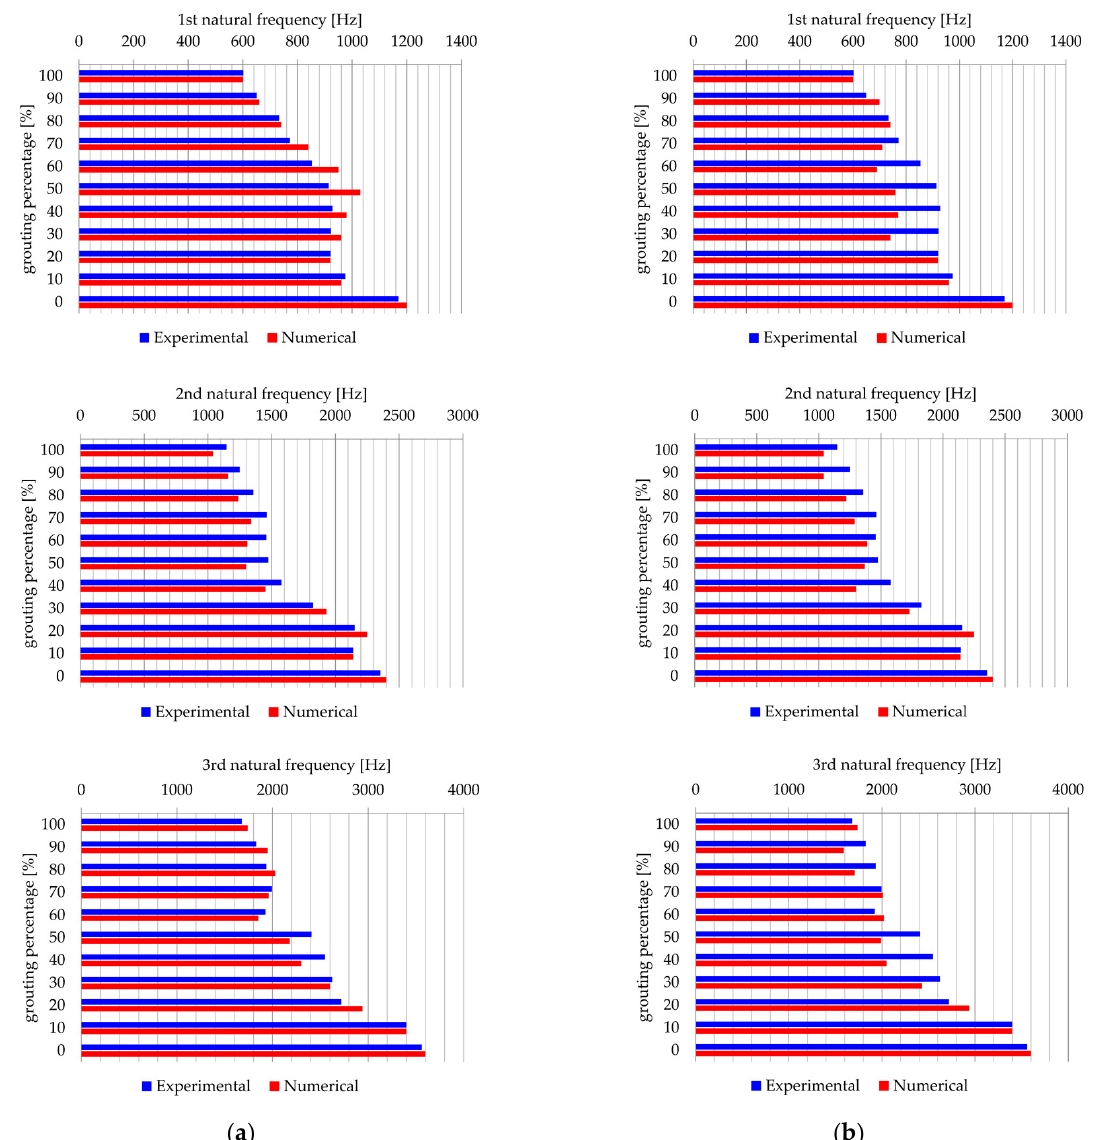
Figure 13. Comparison of the values of first, second, and third calculated natural frequency and experimentally obtained values for: ( a ) Group I and ( b ) Group II.